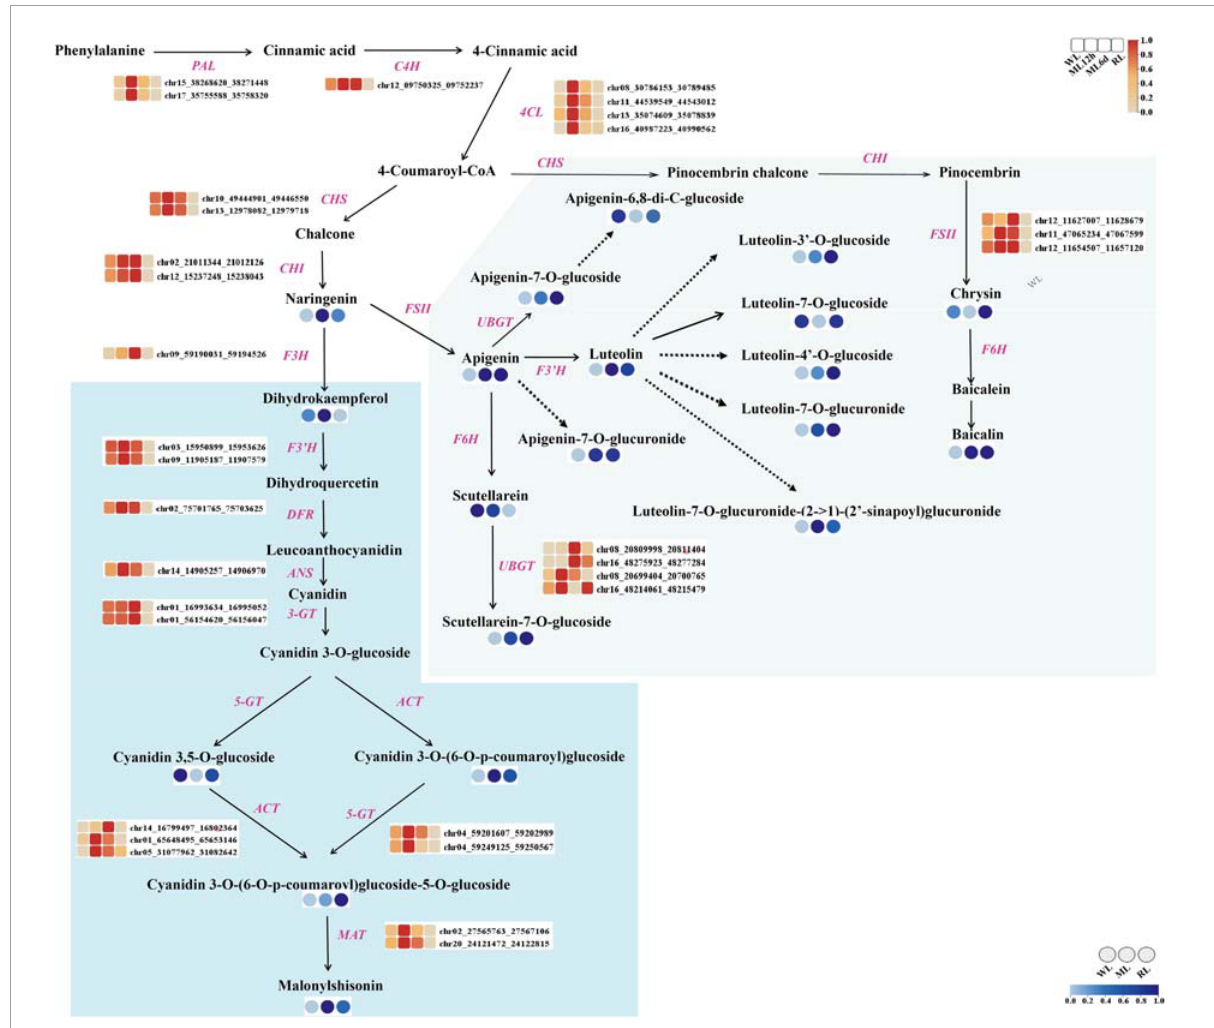
FIGURE4 The metabolites and genes involving in the anthocyanin biosynthesis pathway under different light intensity treatments in perilla leaves. The blue background indicates the major malonylshisonin biosynthetic pathway. The green background indicates the major flavonoid biosynthetic pathway. The blue color in the circle indicates the level of the metabolite under WL, ML, and RL treatment. The red color in the blocks represents the relative expression levels of genes under WL, ML12h, ML6d, and RL treatments. PAL, phenylalanine ammonia lyase; C4H, cinnamate 4-hydroxylase; 4CL, 4-coumarate-CoA ligase; CHS, chalcone synthase; CHI, chalcone isomerase; F3H, flavanone 3-hydroxylase; F3’H, flavonoid 3’-hydroxylase; DFR, dihydroflavonol reductase; ANS, anthocyanin synthase (leucoanthocyanin dioxgenase); 3-GT, flavonoid 3-glucosyltransferase; ACT, anthocyanin acyltransferase; 5-GT, anthocyanin 5-glucosyltransferase; MAT, anthocyanin